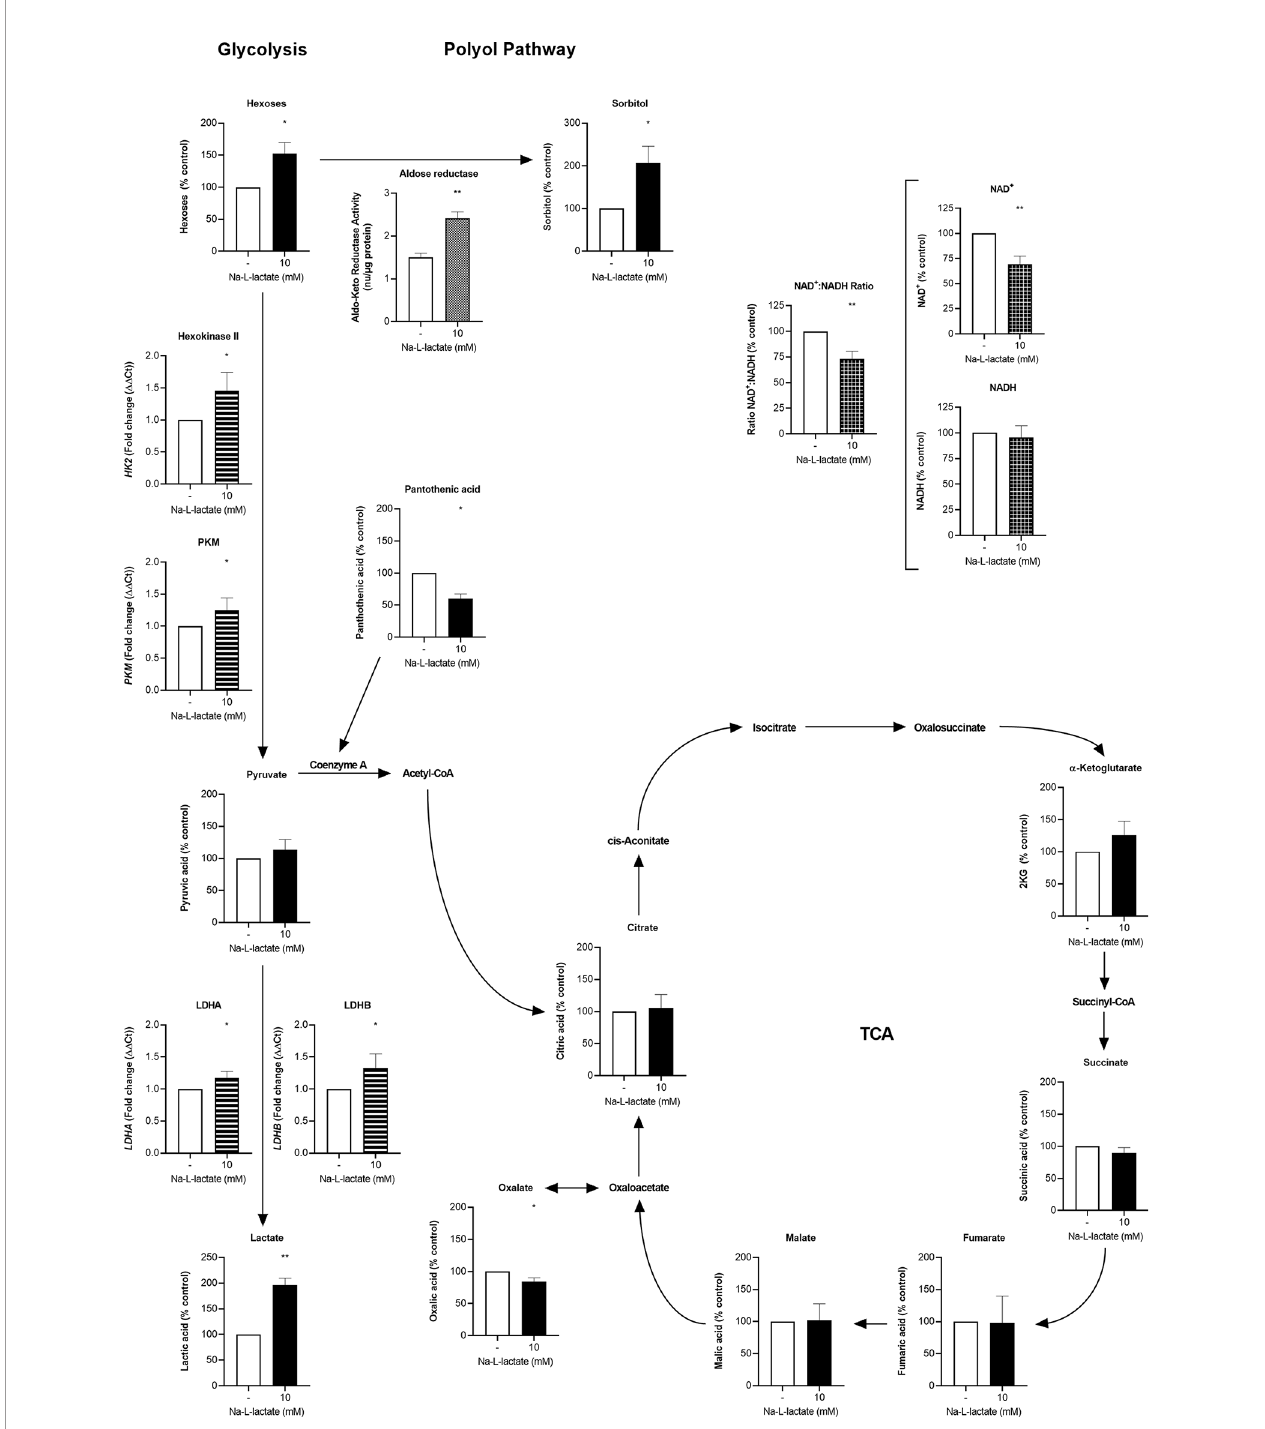
FIGURE 3 | Extracellular lactate plugs glycolysis and increases turnover in the branching polyol pathway. Intracellular concentration ( fi lled columns) of hexoses, sorbitol, pyruvate, lactate, pantothenic acid, citrate, a -ketoglutarate, succinate, fumarate, malate, oxalate (n=3), NAD + , NADH (white checkered columns), and aldose reductase (white dotted column) activity, and gene expression (white striped columns) of HK2 , PKM , LDHA , and LDHB (n=5) after one-hour priming with 10mM Na- L-lactate and six hours stimulation with LPS. Data are shown as mean + SD, except for aldose reductase activity, where mean + SEM are shown. One sample t tests were performed against the theoretical values 100 or 1 respectively. Group comparison for aldose reductase activity was performed by unpaired t test (** P ≤ 0.01, * P ≤